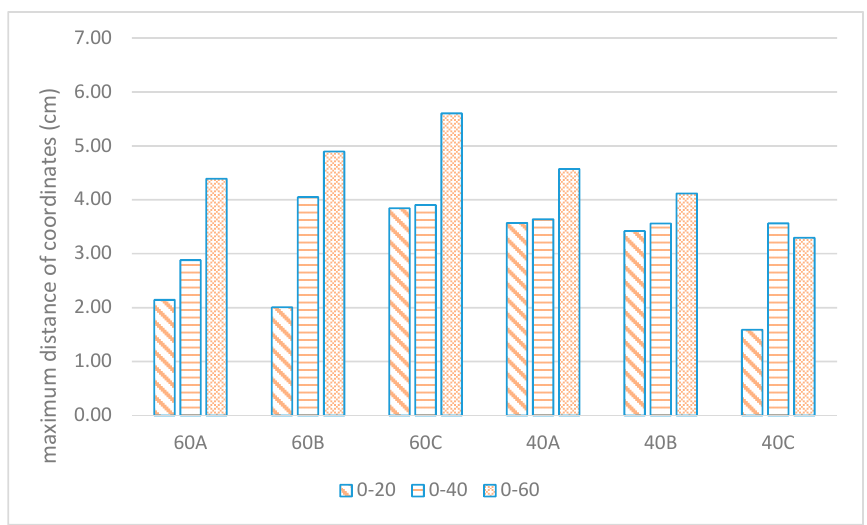
Figure 8. Average maximum AESL along the x -axis.